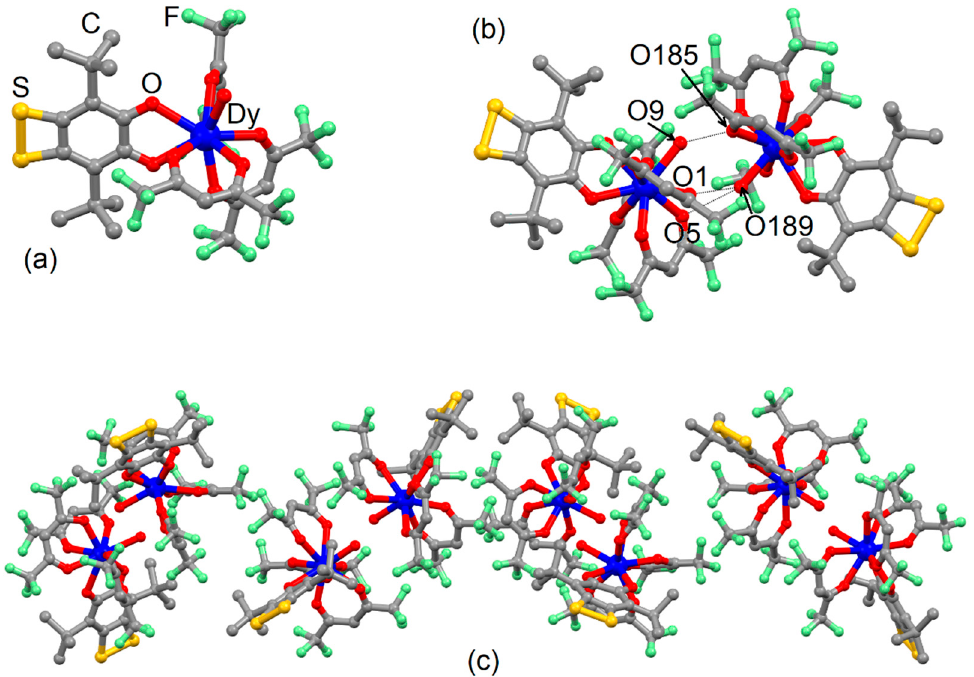
Figure 2. ( a ) Molecular structure, ( b ) formation of the dimer through multiple hydrogen bonds highlighting in dashed lines and ( c ) the crystal packing in the plan (101) for 2 . Color code: gray: carbon, blue: dysprosium, red: oxygen, green: fluorine and yellow: sulfur.